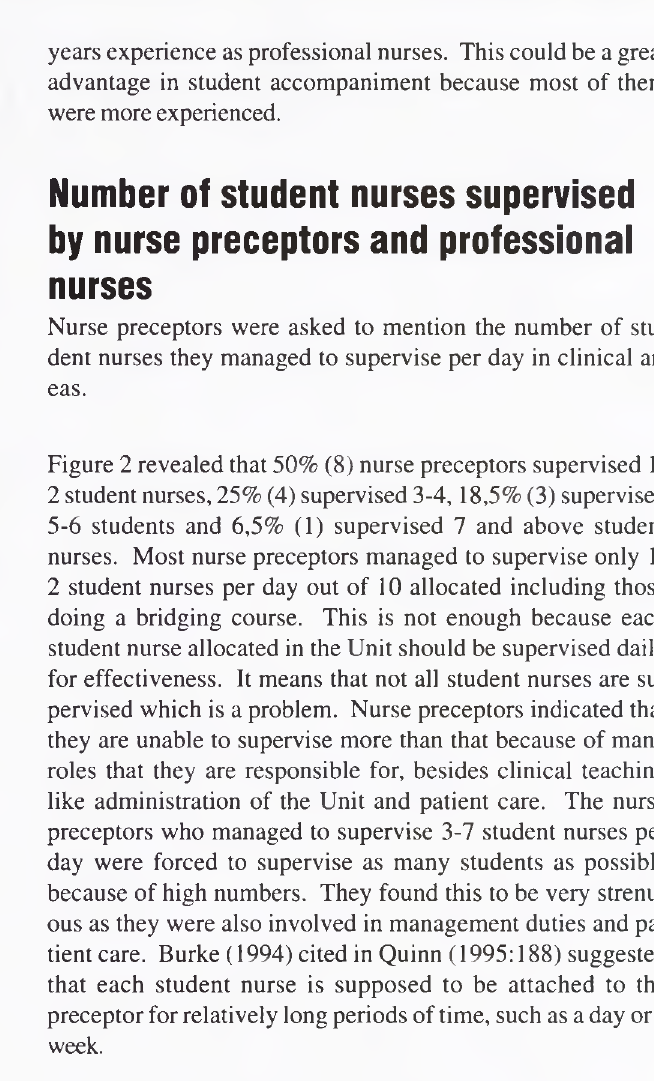
Figure 1 : Experience of nurse preceptors in years